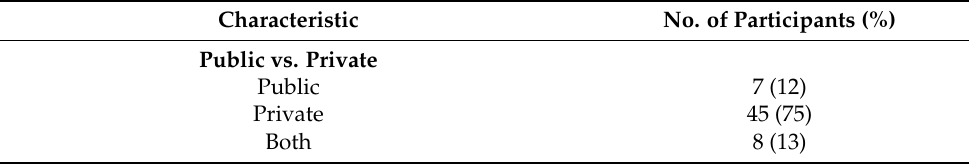
Table 1. General practitioner characteristics (N = 60). Data are presented as n (%).